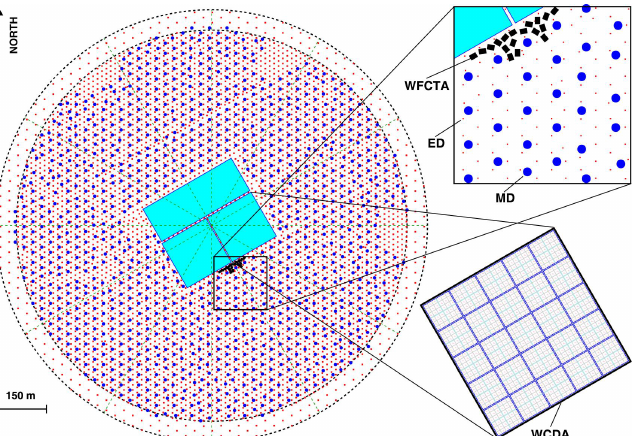
Figure 3. Schematic of LHAASO layout. Red dots represent 5216 EDs distributed in the inner circular array of 1 km 2 with the spacing of 15 m, and in the outer ring with the spacing of 30 m. The sub-array in the ring is for vetoing showers which have cores outside the 1 km 2 array. Blue filled circles represent 1188 MDs in the 1 km 2 array with the spacing of 30 m. Light blue rectangles at the center of the site and enlarged represent WCDA in three ponds. Enlarged pond has 900 units that are divided into 25 clusters and covering an area of 150 m × 150 m. Black rectangles near the WCDA represent 18 telescopes in WFCTA. In the enlarged part, the detailed locations and orientations of the telescopes are indicated as